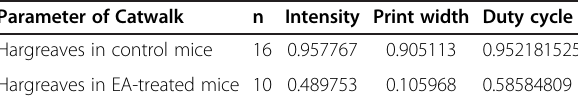
Table 2 Pearson coefficient between time latency of the Hargreaves test and the CatWalk parameters Parameter of